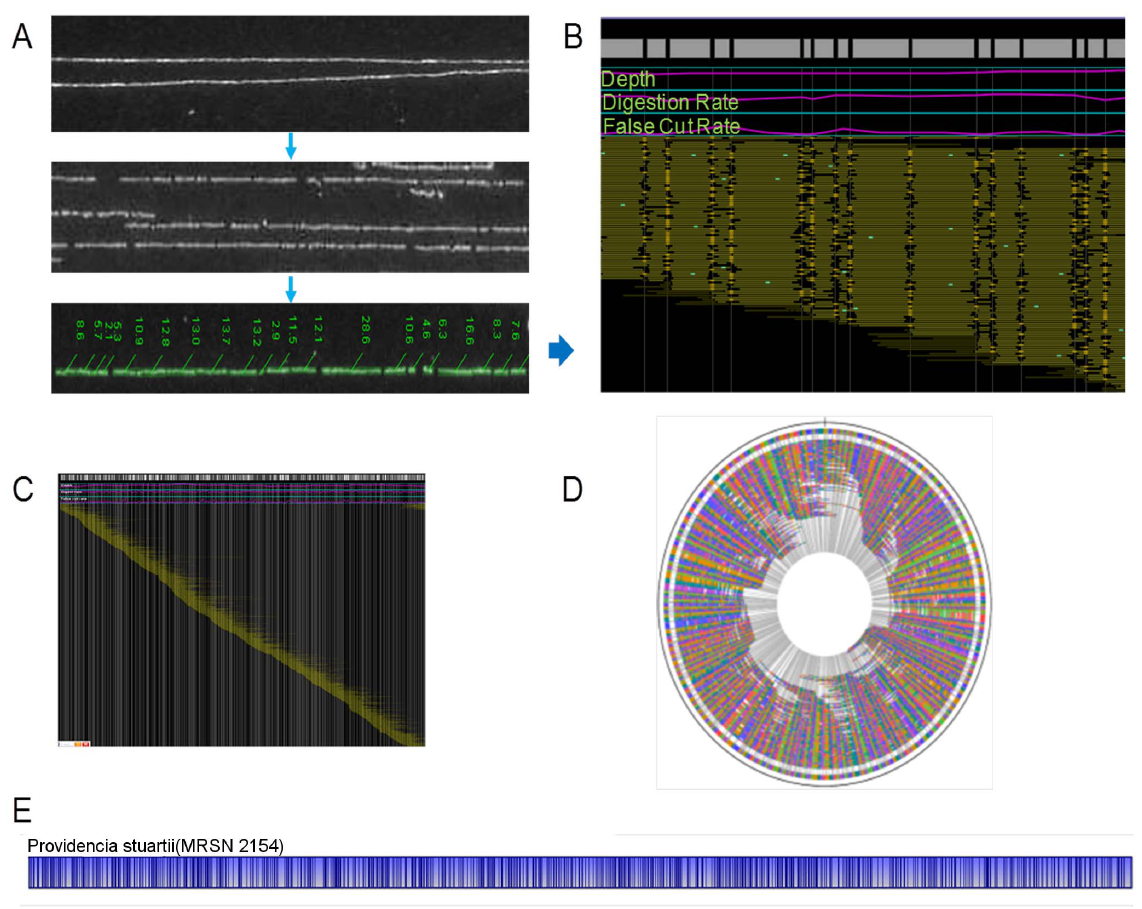
Figure 3. Construction of a whole-genome restriction map for Providenciastuartii MRSN 2154. ( A ) Genomic DNA was immobilized, in situ digested with NcoI enzyme, measured and converted to a digital profile. Black gaps within single DNA molecules are breaks created by restriction digestion. ( B ) DNA molecule restriction patterns were aligned to generate WGRM contigs. Each green horizontal line represents a single DNA molecule. Gray blocks represent the consensus DNA restriction fragments. Black vertical lines represent consensus restriction cut sites. ( C ) WGRM contigs aligned to create continuous coverage along the DNA strand, producing the whole-genome consensus map. ( D ) Circular representation of the linear consensus map which has an estimated size of 4.2 Mb. ( E ) The MRSN 2154 consensus genome map displayed by the MapSolver program. The circular map is illustrated in a linear view. NcoI restriction sites are indicated as vertical bars.